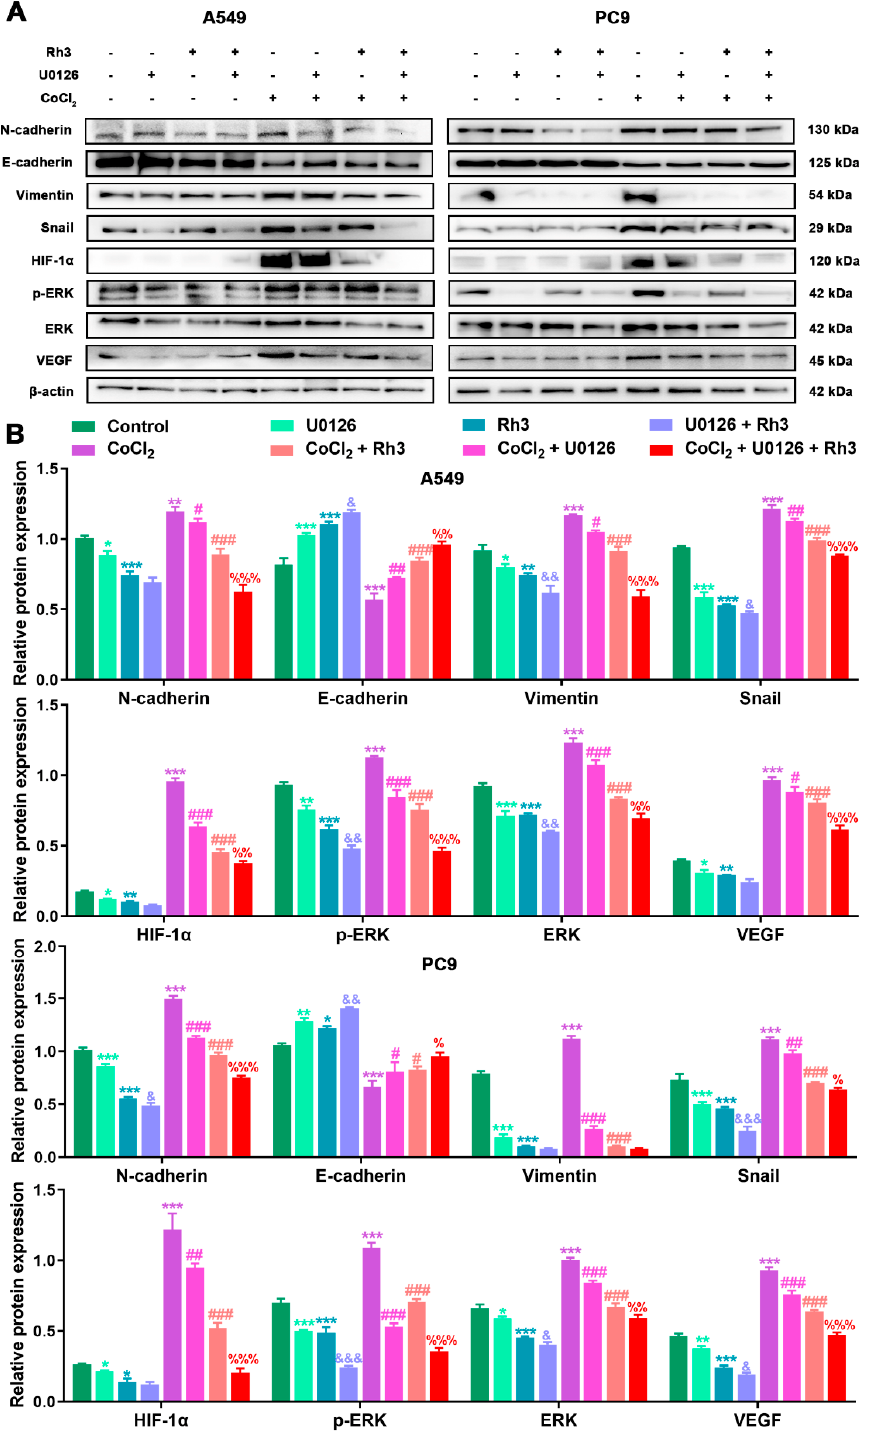
Figure 7. U0126 enhances Rh3 action in relation to the EMT process and the ERK pathway in A549 and PC9 cells. ( A ) HIF-1 α , ERK, p-ERK, VEGF, and EMT-related protein expression in A549 and PC9 cells following treatment with 40 μ M Rh3, 10 μ M U0126, and 100 μ M CoCl 2 . ( B ) Protein expression is represented by the histograms. * p < 0.05, ** p < 0.01, *** p < 0.001 compared with the control group; # p < 0.05, ## p < 0.01, ### p < 0.001 compared with the CoCl 2 group; & p < 0.05, && p < 0.01, &&& p < 0.001 compared with the Rh3 group; % p < 0.05, %% p < 0.01, %%% p < 0.001 compared with the CoCl 2 + Rh3 group.